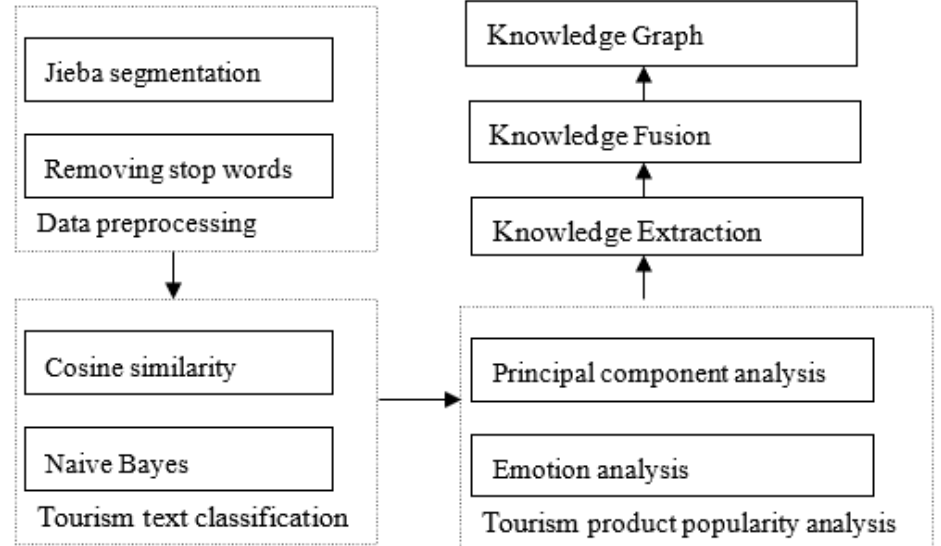
Figure 5. Construction process for the tourism knowledge graph.